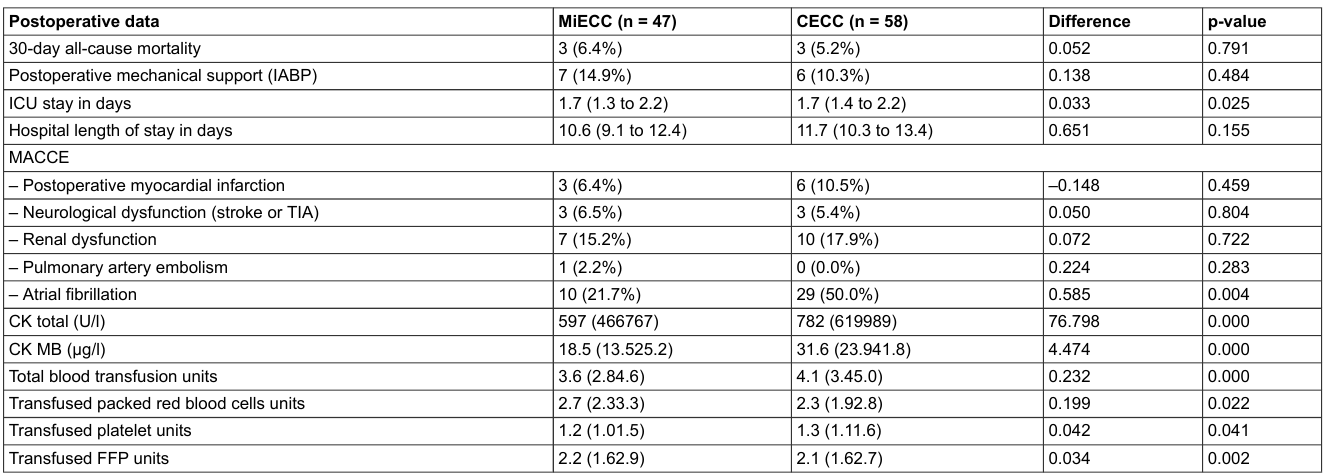
Table S3: Postoperative data before propensity score matching and before inverse probability of treatment weighting